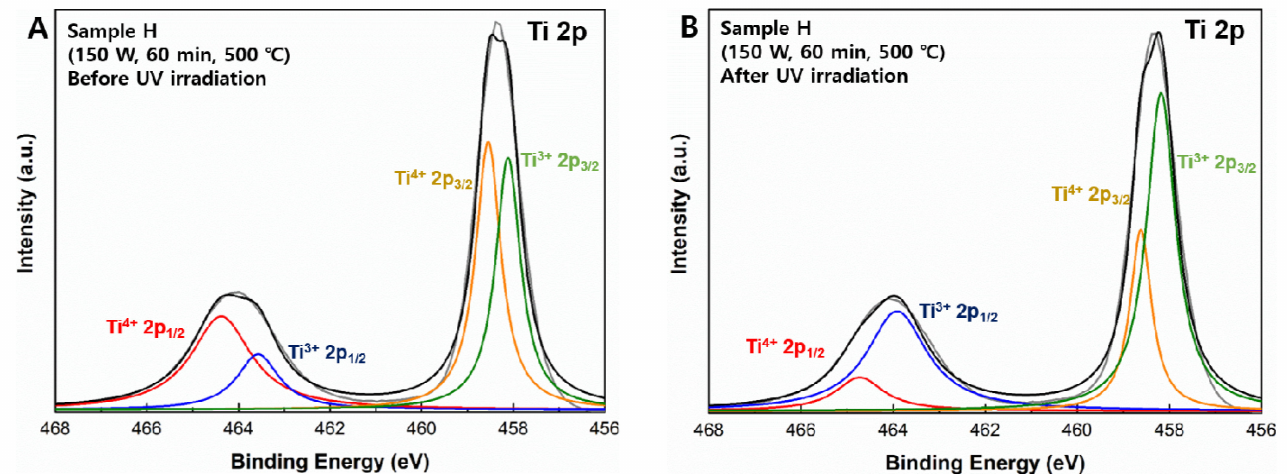
Figure 4. Ti 2p XPS profiles ( A ) before UV irradiation and ( B ) after UV